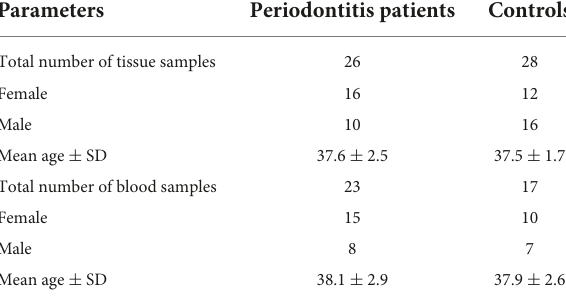
TABLE 2 General features of study participants.